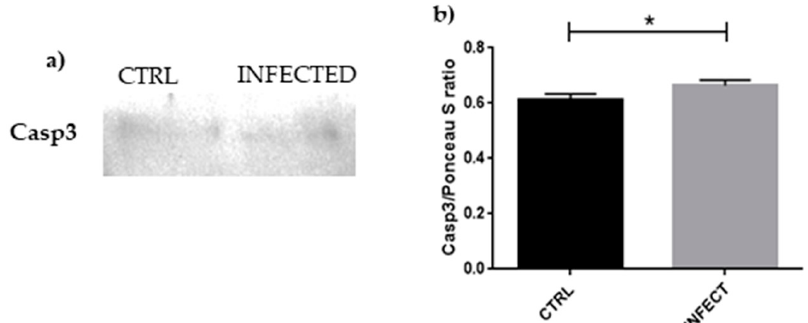
Figure 5. ( a ) Evidence of significant increase in caspase 3 expression in HCN-2 culture medium after SARS-CoV-2 infection, suggesting that apoptosis is taking place in the infected cells; ( b ) densitometric analysis of caspase 3, * p < 0.05.